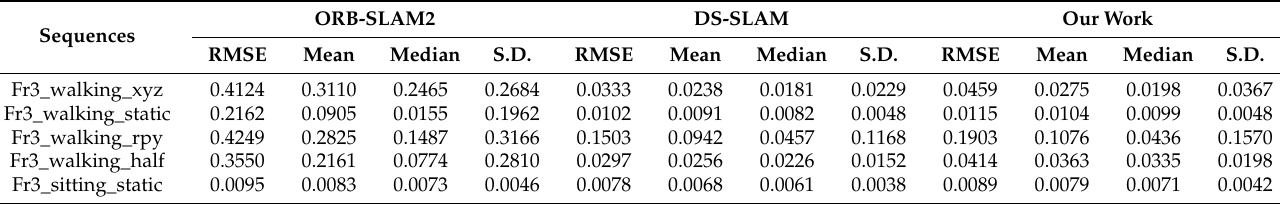
Table 5. The results of metric translational drift